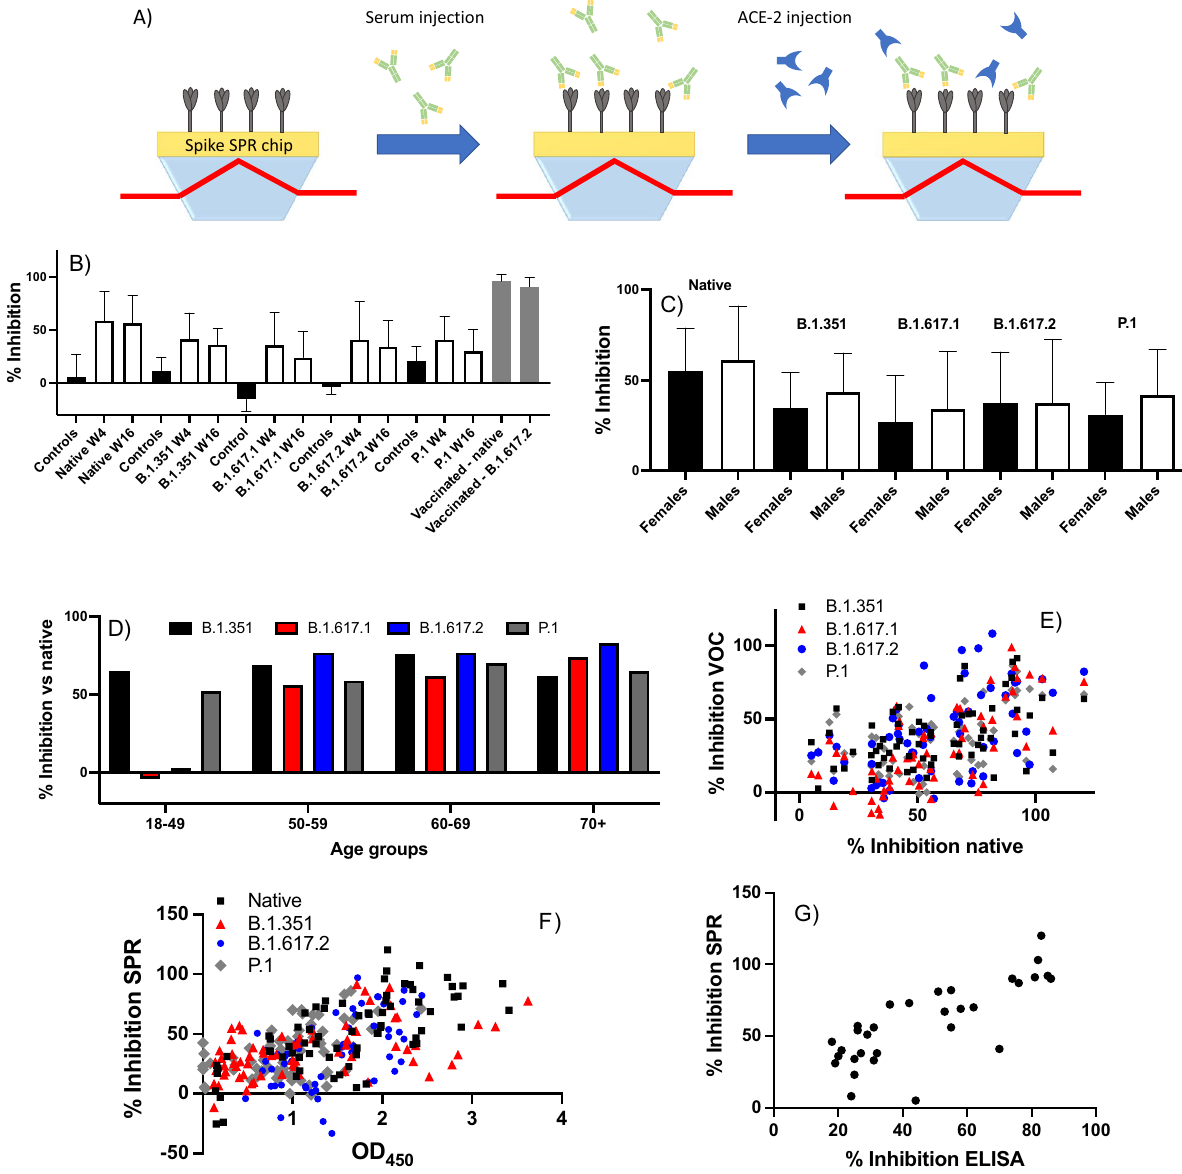
Figure 4. ( A ) Schematic illustrating the principle of the SPR pseudo-neutralization assay to quantify the inhibition of the interaction between spike protein and ACE-2 in the presence of SARS-CoV-2-positive sera. Serum from an individual who tested positive for SARS-CoV-2 is injected onto an SPR chip that has been functionalized with spike protein, and a preparation of recombinant human ACE-2 is subsequently injected. A reduced SPR response (and thus higher percent inhibition) is observed if the serum antibodies inhibit the spike–ACE-2 interaction. ( B ) Observed inhibition of the interaction of ACE-2 with native, B.1.351, B.1.617.2, and P.1 spike proteins by variant-naïve SARS-CoV-2-positive sera (n = 32). Controls: SARS-CoV-2-negative sera (n = 8). Error bars represent one standard deviation. ( C ) Observed inhibition of the interaction of ACE-2 with native, B.1.351, B.1.617.2, and P.1 spike proteins by variant-naïve SARS-CoV-2-positive sera as a function of sex (females: n = 18; males: n = 14). ( D ) Normalized inhibition for the B.1.351, B.1.617.1, B.1.617.2 and P.1 variants expressed as a percentage of inhibition compared to the native spike protein for the same age group (n = 8 for each age group). Data from weeks 4 and 16 are pooled. ( E ) Correlation between the percent inhibition (for weeks 4 and 16 post-diagnosis combined) observed for native and for the B.1.351, B.1.617.1, B.1.617.2 and P.1 spike proteins; each dot corresponds to an average of 2 replicates for a single individual (n = 31 or 32 depending on the data sets). ( F ) Correlation between the ELISA OD 450 results (Fig. 1 and Tables S1, S2) and pseudo- neutralization results for weeks 4 and 16 combined (n = 31 or 32 depending on the data sets). ( G ) Correlation between the ELISA and SPR pseudo-neutralization results obtained with the native spike protein for the samples at week 4 (n =